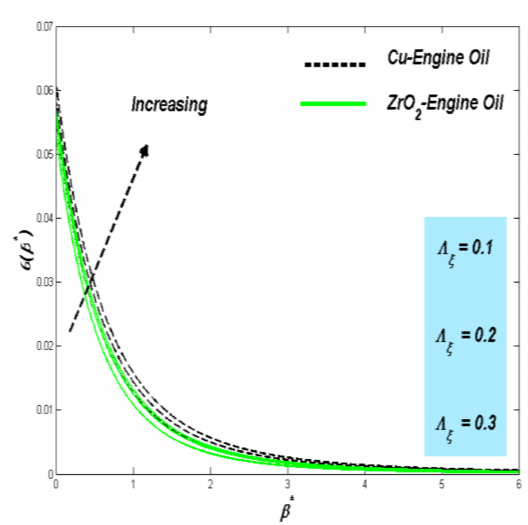
Figure 12. Temperature profile change with Λ ξ .